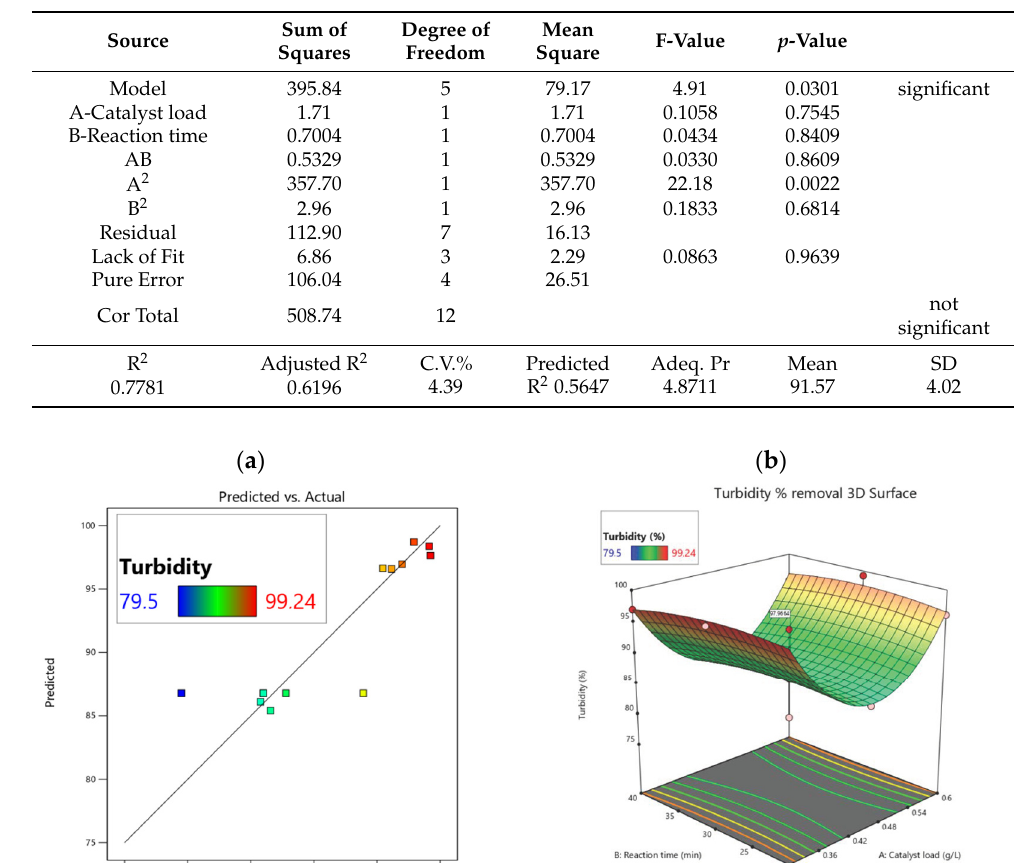
Table 5. ANOVA for quadratic model for response 1: turbidity.